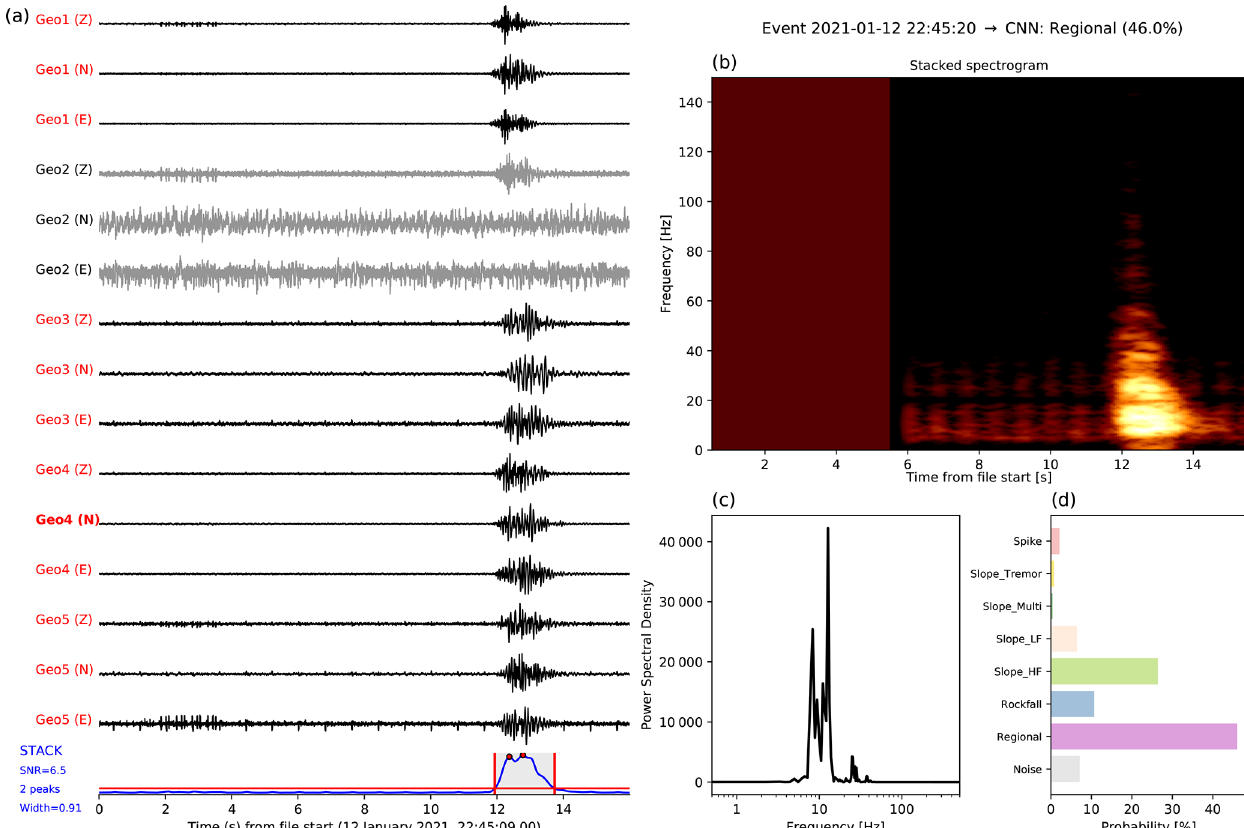
Figure B17. Example of an event wrongly classified as a regional earthquake instead of an HF slope quake; see Fig. 4 for description. Note that we only display the waveforms at geophones 1 to 5, since geophones 6–8 were not functional. The event file contains two events and detected electric noise at around 2s. A mask was applied on the spectrogram image but cannot prevent misinterpretation. However, (d) illustrates that the probability of being a regional event is relatively low (below 50%) and the probability of being an HF slope quake is not much